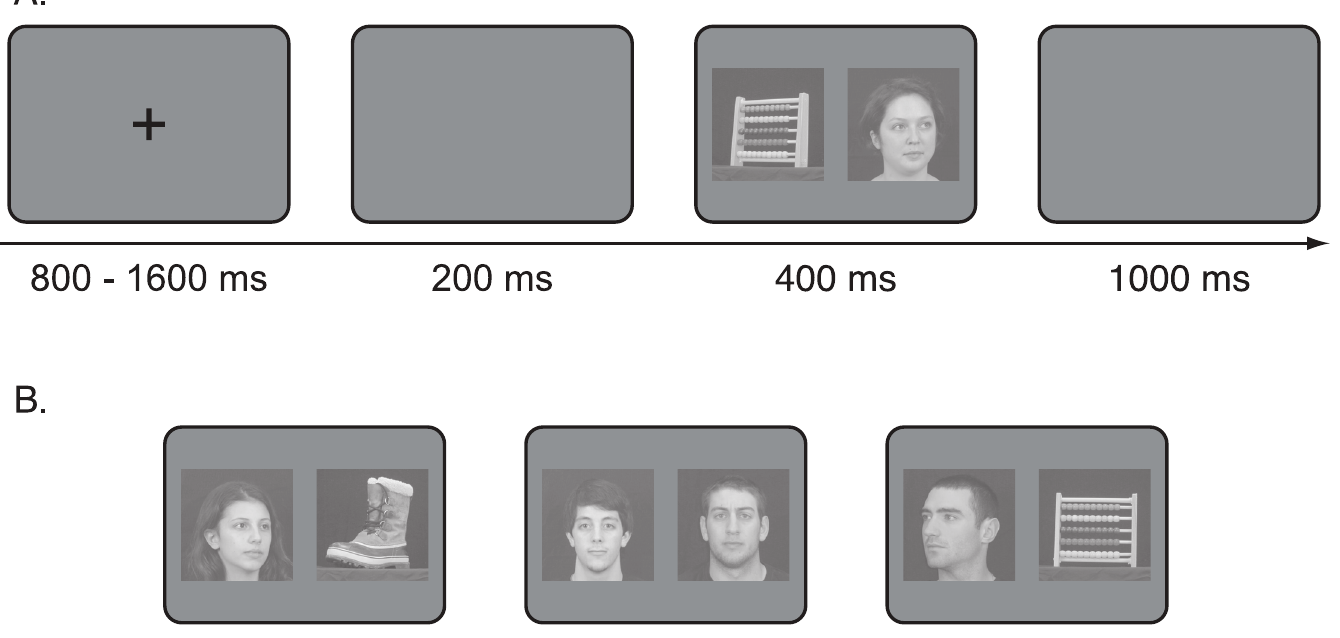
Fig 1. Example of the paradigm (A) with stimuli used in the experiment